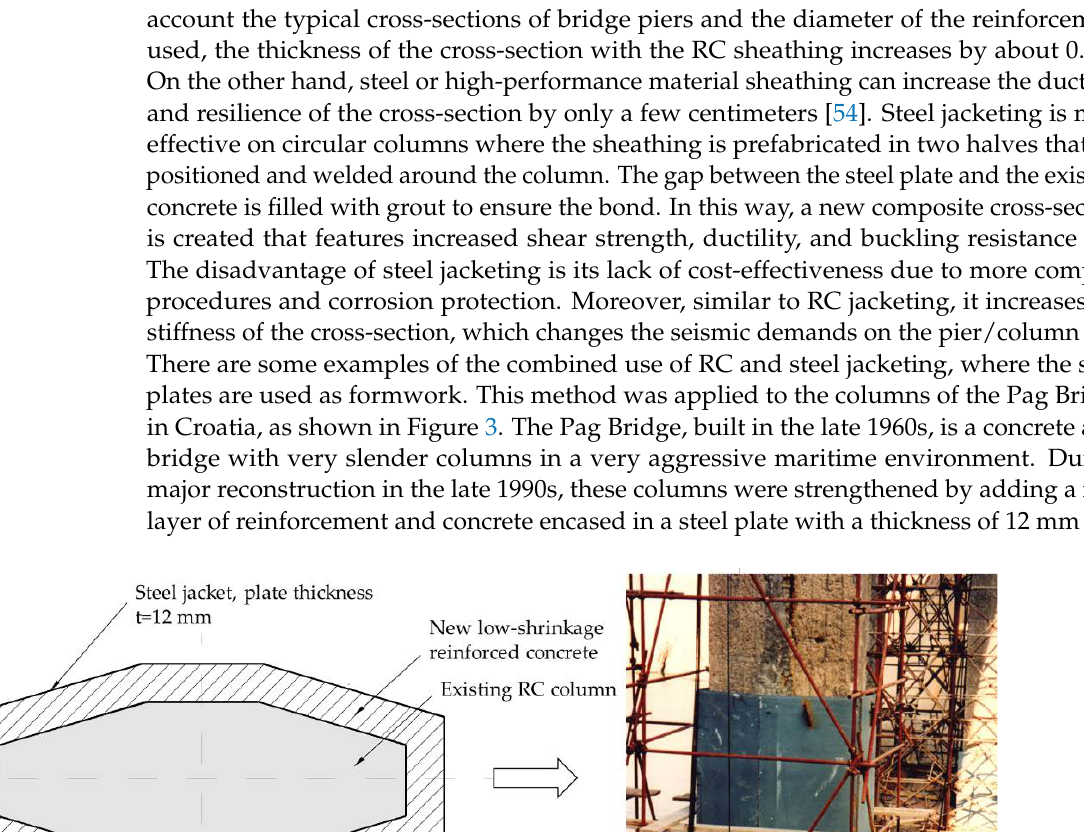
Figure 3. Seismic retrofitting of RC columns on Pag Bridge in Croatia showing the combination of RC and steel jacketing.